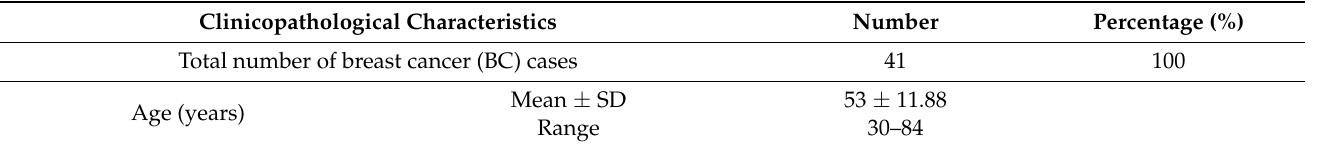
Table 1. Clinical and pathological characteristics of the Lebanese breast cancer patients participating in this study. Normal weight BC patients have BMI values >20 and <24.9 kg/m 2 , while overweight/obese BC patients have BMI values >25 kg/m 2 . The American Joint Committee on Cancer (AJCC) TNM staging system was used to indicate tumor size, lymph node involvement, and distant